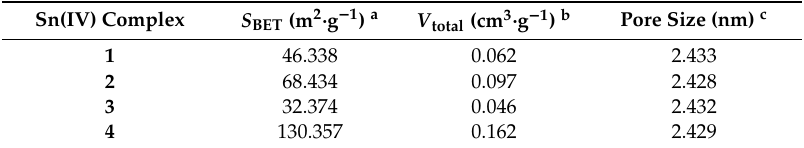
Table 5. Porosity properties of complexes 1 – 4 .